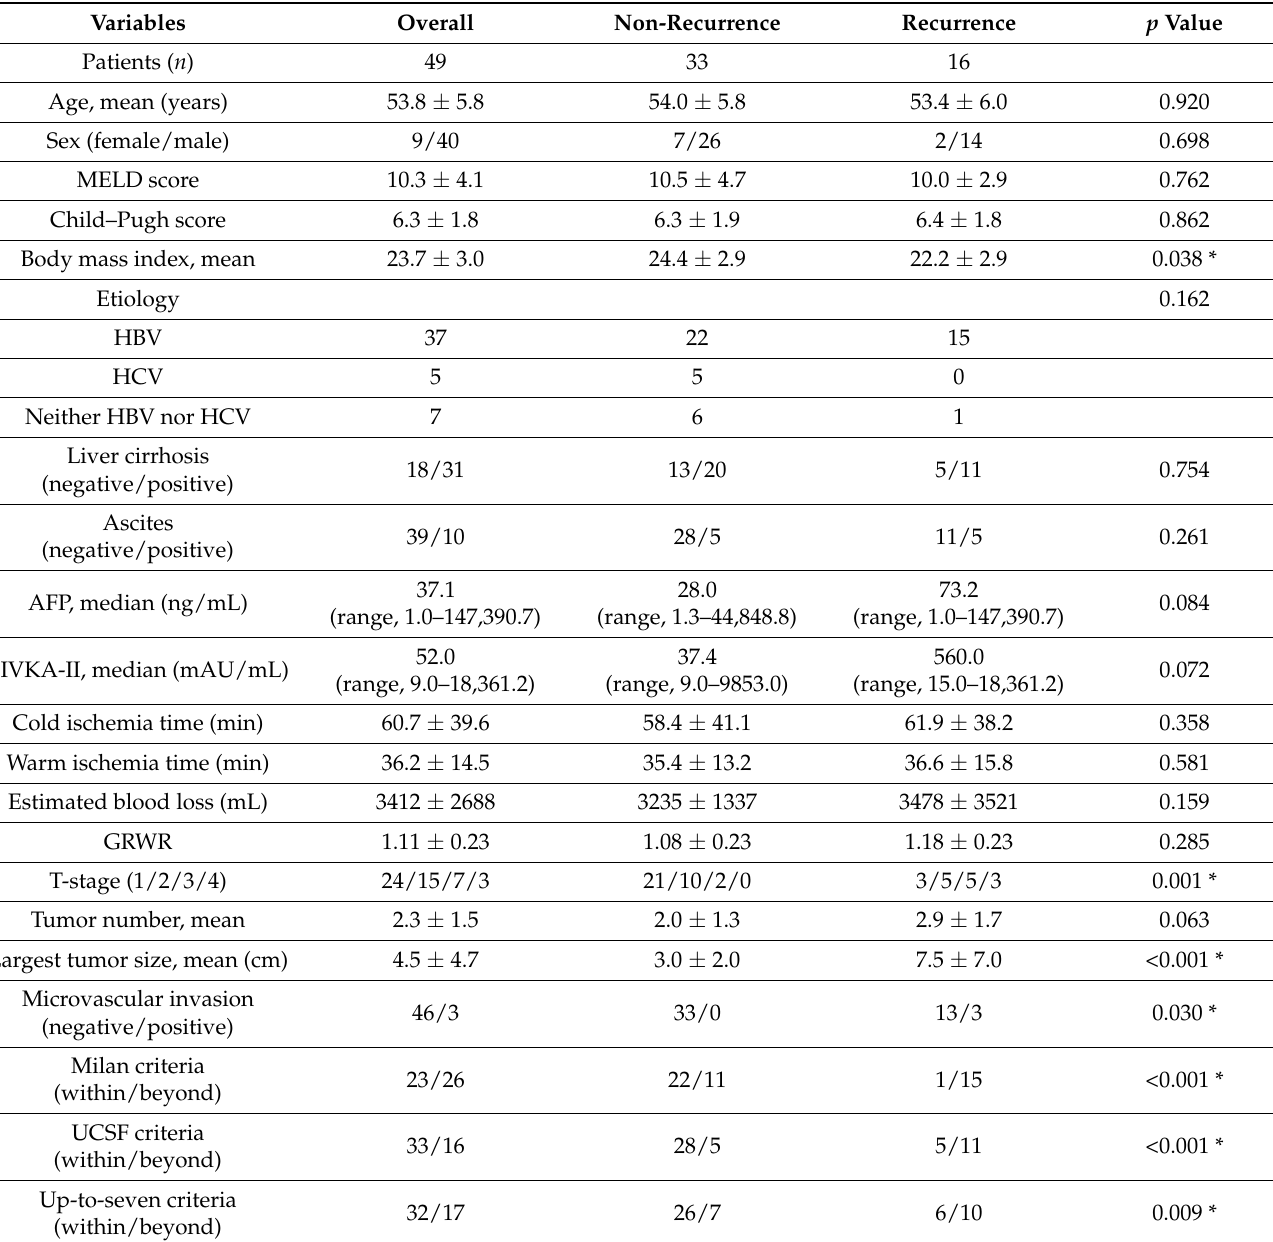
Table 1. Clinicopathological characteristics of